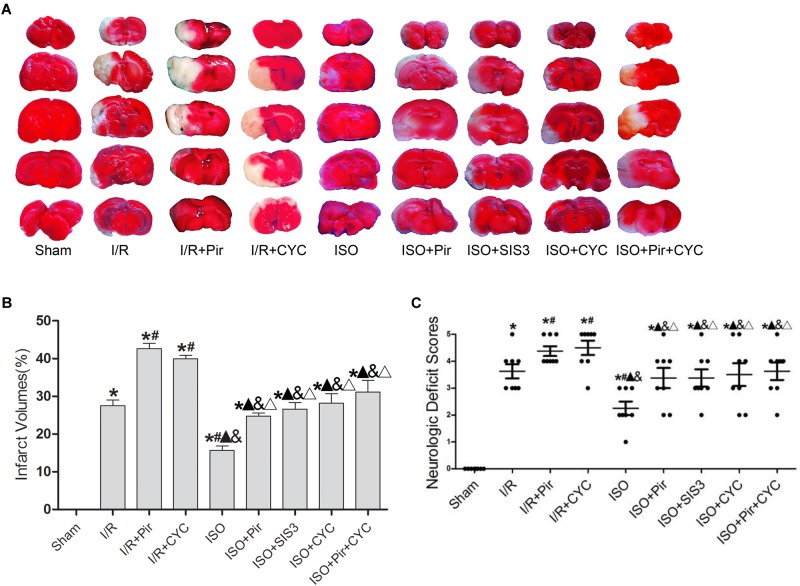
ISO post-conditioning improved infarct volumes and Neurologic Deficit Scores. (A) showed infarct volumes were assessed by TTC. Red represented normal tissue and white represented infarct tissues. (B) showed the quantitative data of infarct volumes. (C) showed neurological function scores with the modified Longa score. Data are shown as the mean ± SD (n = 8). ∗
P < 0.05 vs. Sham; # P < 0.05 vs. I/R;
P < 0.05 vs. I/R + Pir; & P < 0.05 vs. I/R + CYC; Δ P < 0.05 vs. ISO.